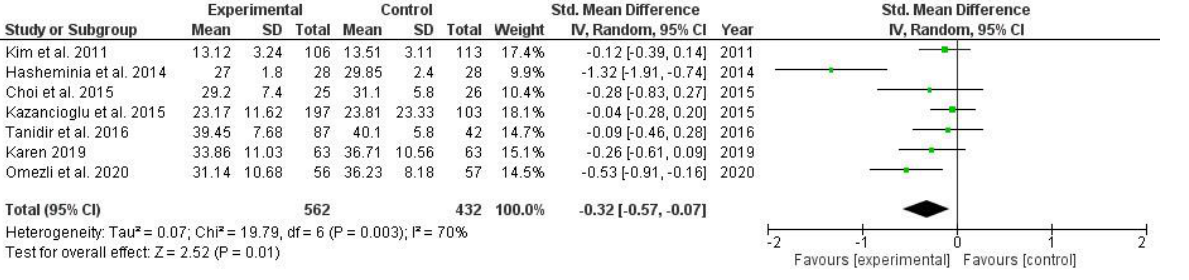
Figure 3. Forest plot of comparison: changes of anxiety levels in non-pharmacological interventions compared with control groups after third molar extraction